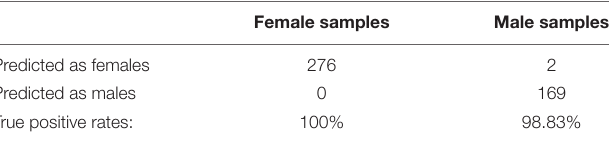
TABLE 1 | Elastic net penalized linear model sex predictions based on odontocetes*, n = 447 (Robeck et al.,